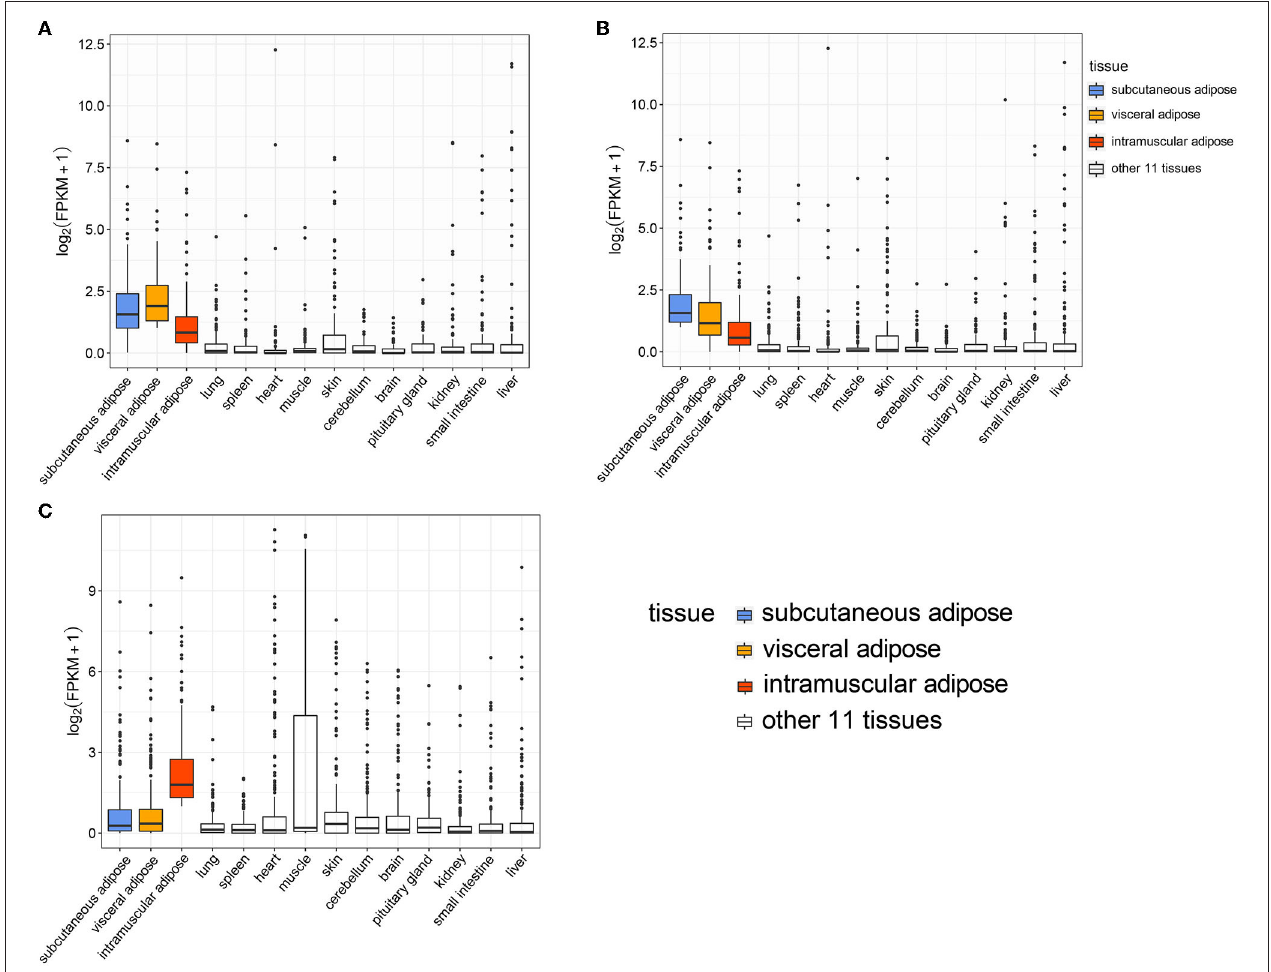
FIGURE 4 | The expression level of visceral adipose (A) , subcutaneous adipose (B) , and intramuscular adipose (C) tissue-specific genes in 14